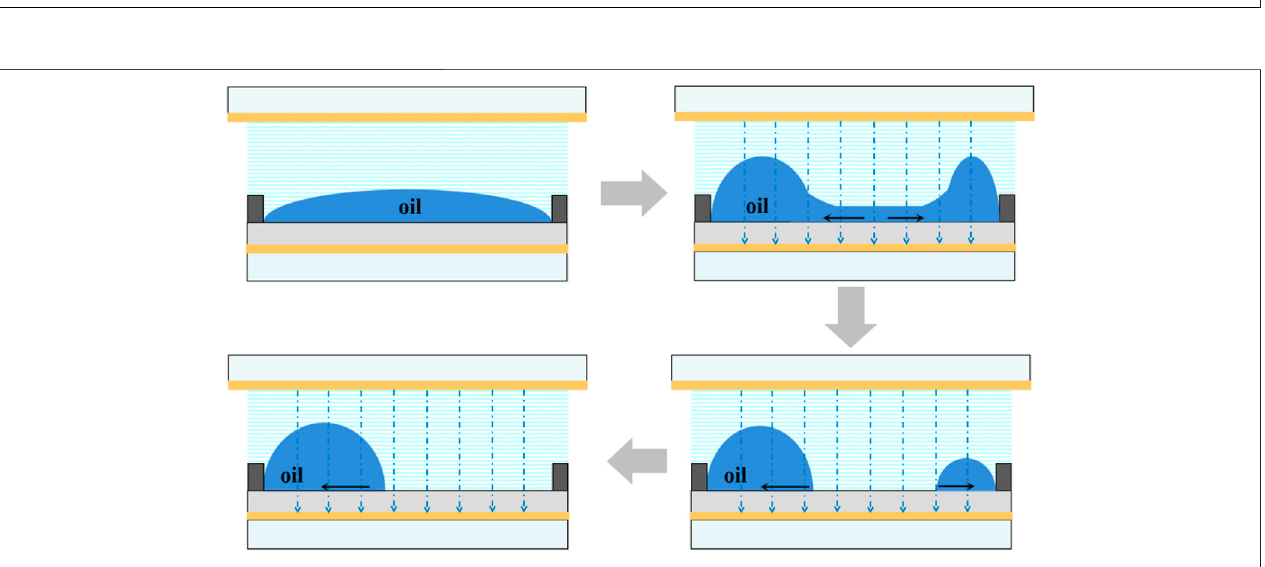
FIGURE 2 | The process of oil fi lm rupture in a pixel from off-state to on-state. For the on-switching process, after applying external electric fi eld force, the oil fi lm begins to rupture with slight fl uctuation. The fl uctuation amplitude becomes larger with the increase of external force, and then, the oil can be shrunk to corners.